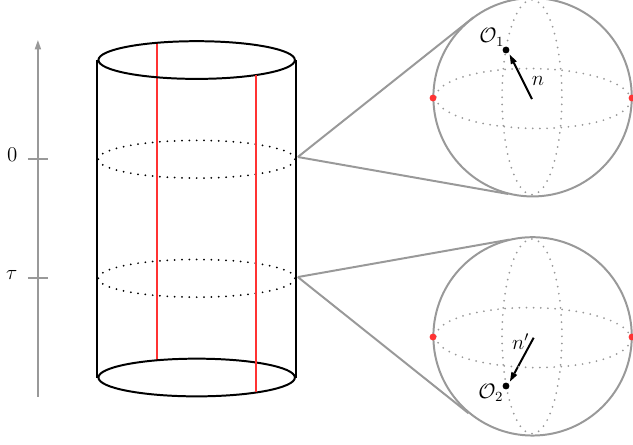
is parametrized by the O 1 is highlighted in gray. D